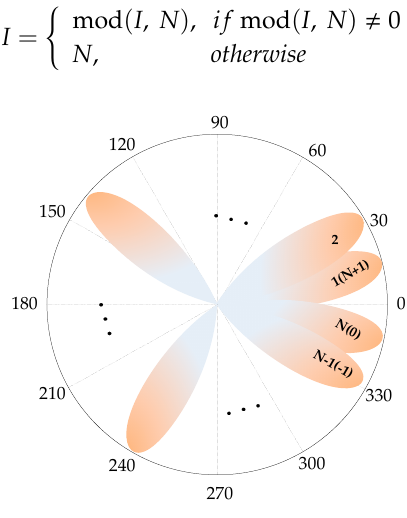
Figure 2. Beam Figure 2. Beam diagram.